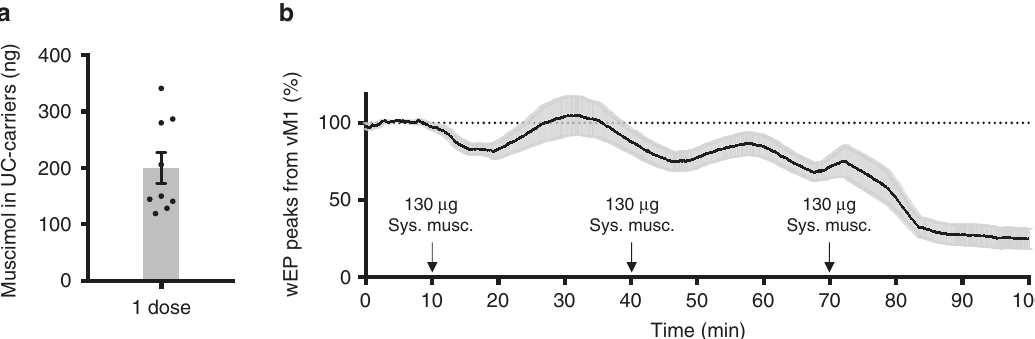
Fig. 4 Focal 1300-fold enhancement of drug response by AU-FUS compared to systemic levels. a LC-HR-MS/MS quanti fi cation of muscimol loaded in one dose of AU-FUS treatment. All data is mean ± s.e.m, showing all points. Average = 199.7 ng, n = 9. b Time course of wEPs (negative peak) in vM1 during systemic injection of muscimol ( “ Sys. musc. ” ). Following 10 min of baseline, 130 μ g of muscimol (~650 times single muscimol-loaded UC-carrier injection dose) is manually injected over 1 min, every 30 min (black arrows). Data is plotted as the moving average (window size = 180 whisker de fl ections). All data is mean ± s.e.m. n = 16 (4 rats × 4 recording sites). Equivalent inhibition by AU-FUS would occur between 260 and 390 μ g